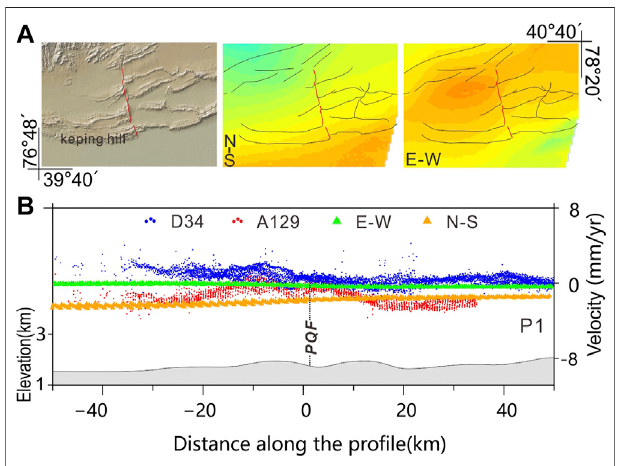
FIGURE 5 | (A) Enlargements of shaded elevation, the N-S and E-W velocity maps overing Piqiang fault, the color bar is the same as Figure 3 . (B) Deformation data pro fi le across Piqiang fault (PQF). See Figures 2 , 3 for P1